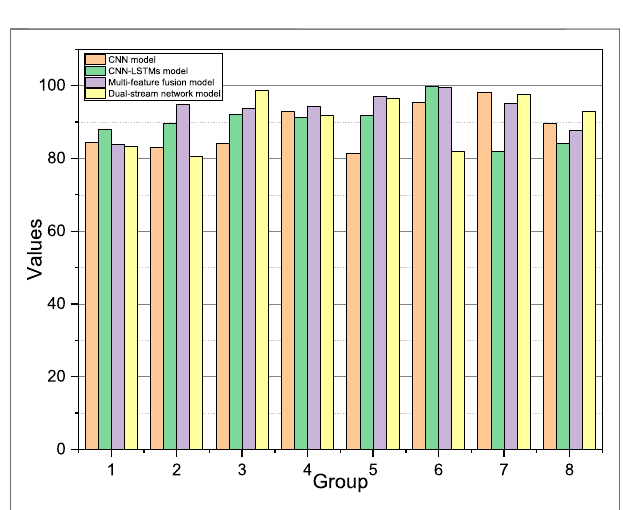
FIGURE 11 | Average accuracy of eight sets of experiments for four models.